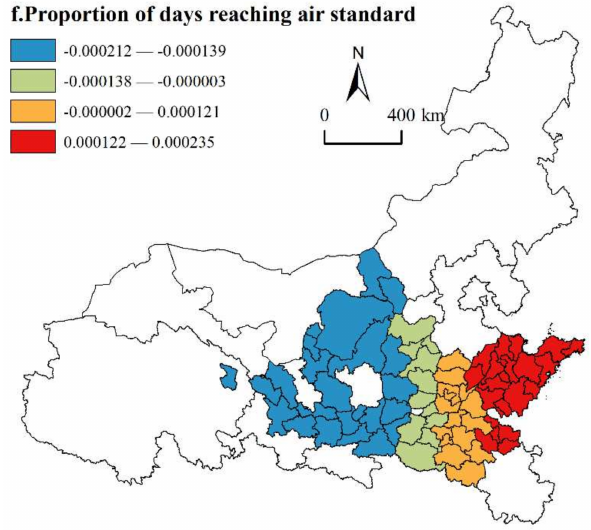
Figure 12. Spatial distribution of proportion of days reaching air